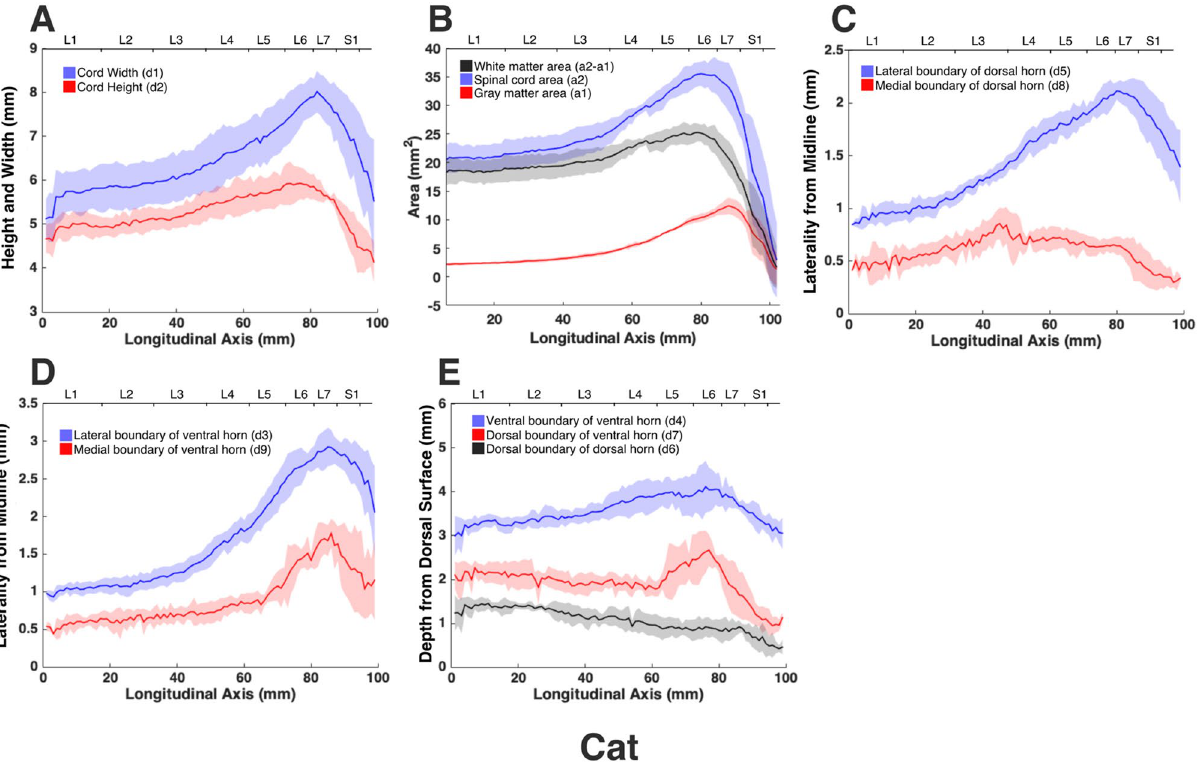
Figure 9. Measurements of cross-sectional dimensions of the spinal cord and locations of the ventral and dorsal horns of cat spinal cord. Presented data are based on n = 6 specimens. Solid lines represent the mean and the shaded regions represent the mean ± standard deviation. ( A ) Spinal cord width and height (d1 and d2, respectively in Fig. 7, left) across the lumbosacral cord. ( B ) Cross-sectional areas of the spinal cord and gray matter (a1, a2 in Fig. 7, right) across the lumbosacral cord. ( C ) Mediolateral distances from midline to the dorsal horn boundaries (d5, d8 in Fig. 7, middle). ( D ) Mediolateral distances from midline to the ventral horn boundaries (d3, d9 in Fig. 7, middle). ( E ) Depth from the dorsal surface of the spinal cord of the ventral and dorsal horn boundaries (d4, d7, d6, in Fig. 7,